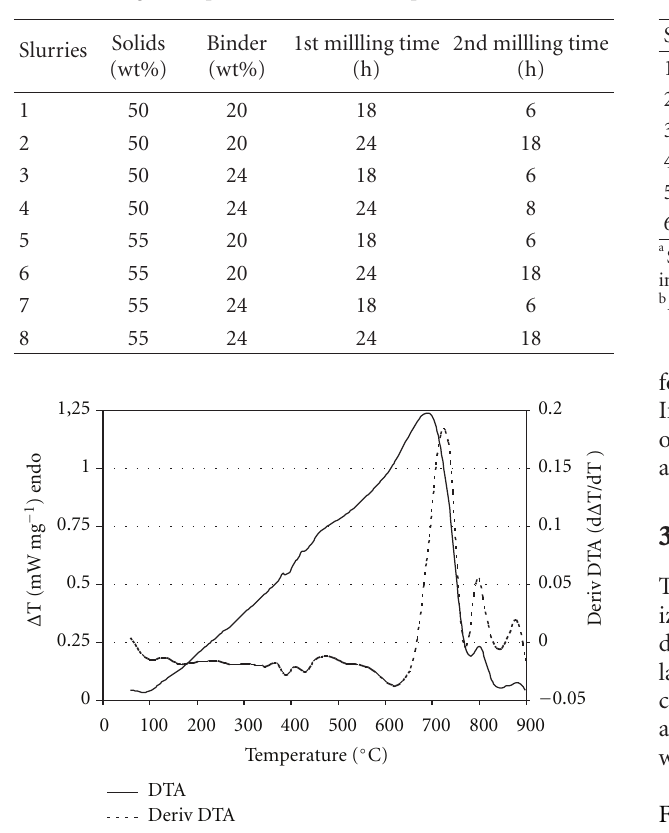
Table 2: Viscosity and pH values of prepared